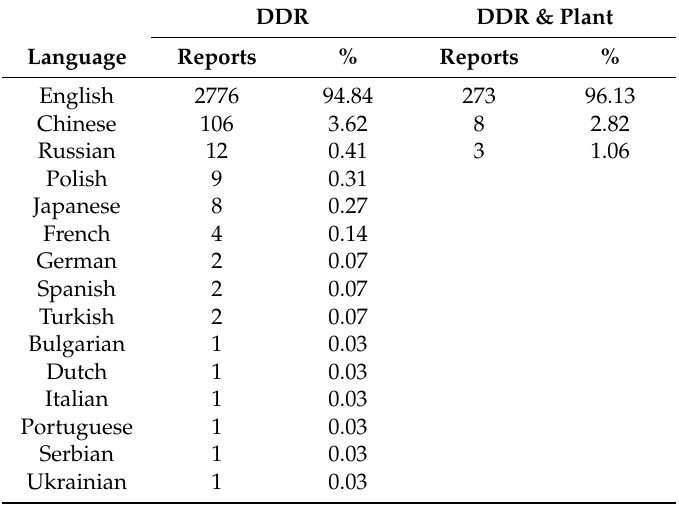
Table 4. Languages of scientific output in the DDR research field and DDR research in the plant